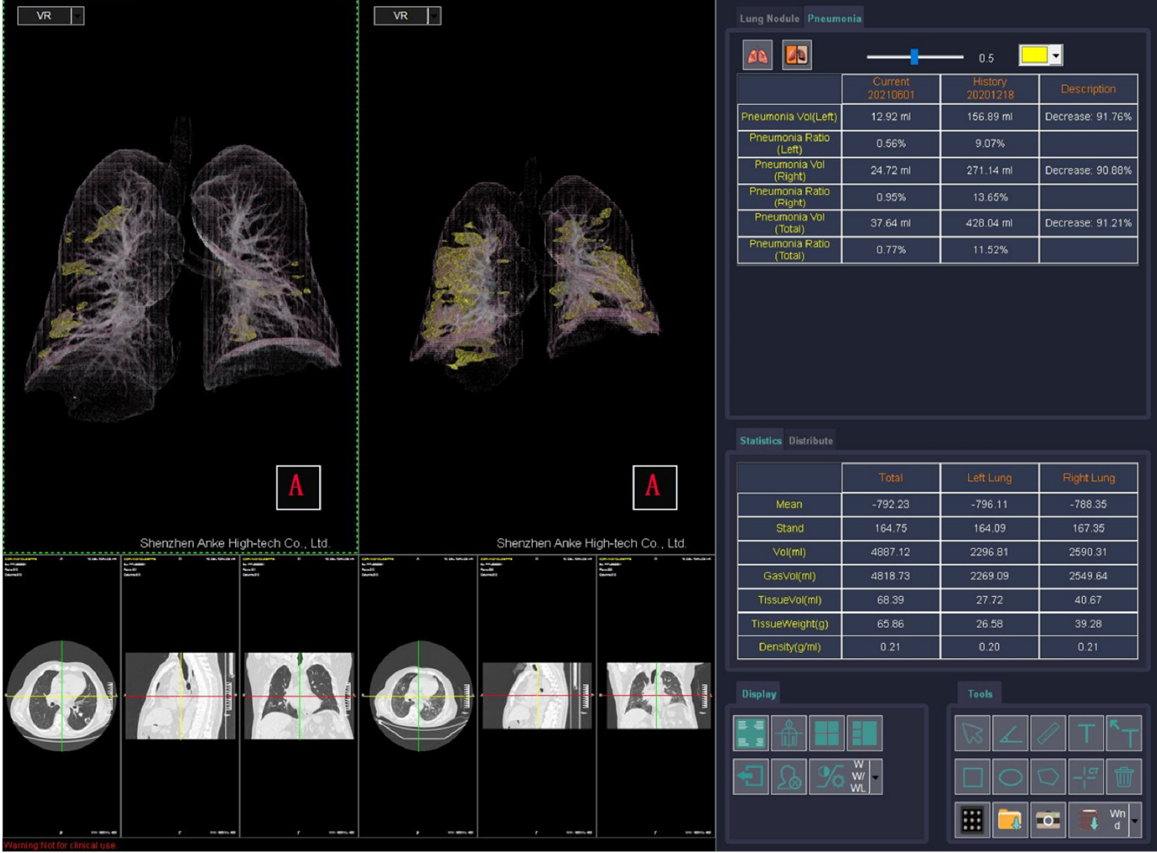
Figure 2. Automatic Segmentation of Thoracic Disease by COVID-19 using the pneumonia tool of ANKE ASG-340 CT workstation.